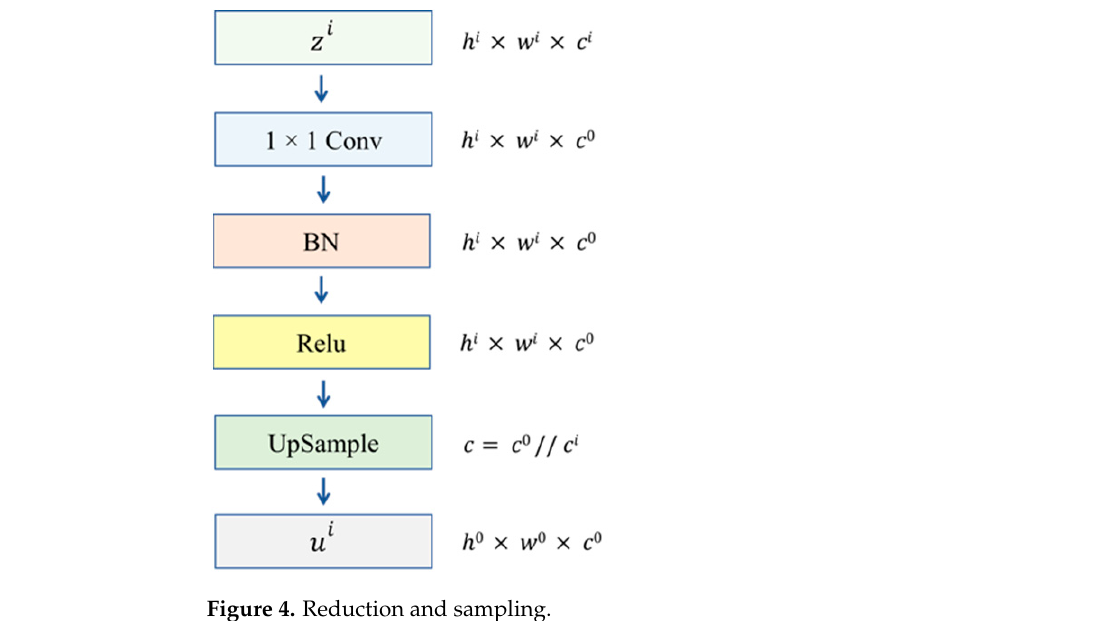
Figure 4. Reduction and